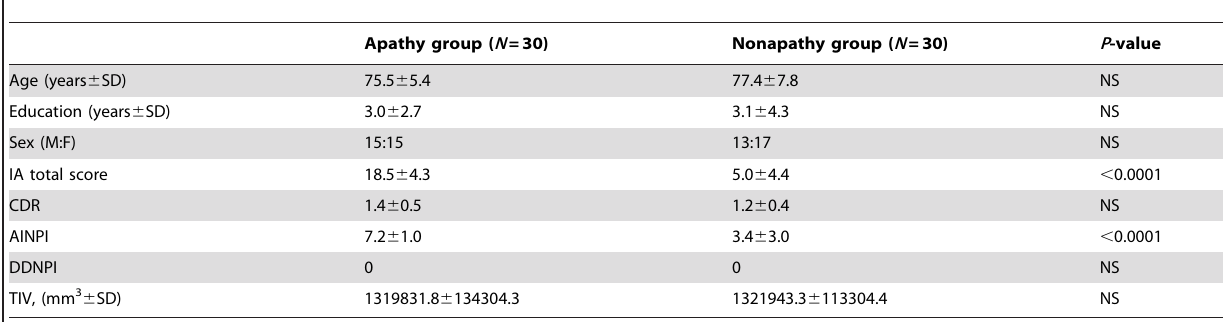
Table 1. Demographic and clinical characteristics of the study participants.